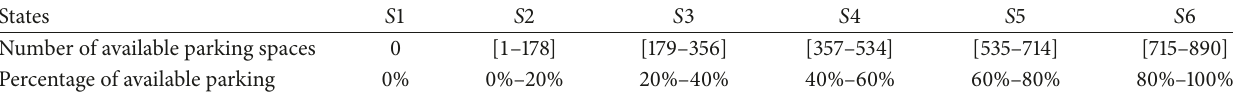
Table 2: States from the data